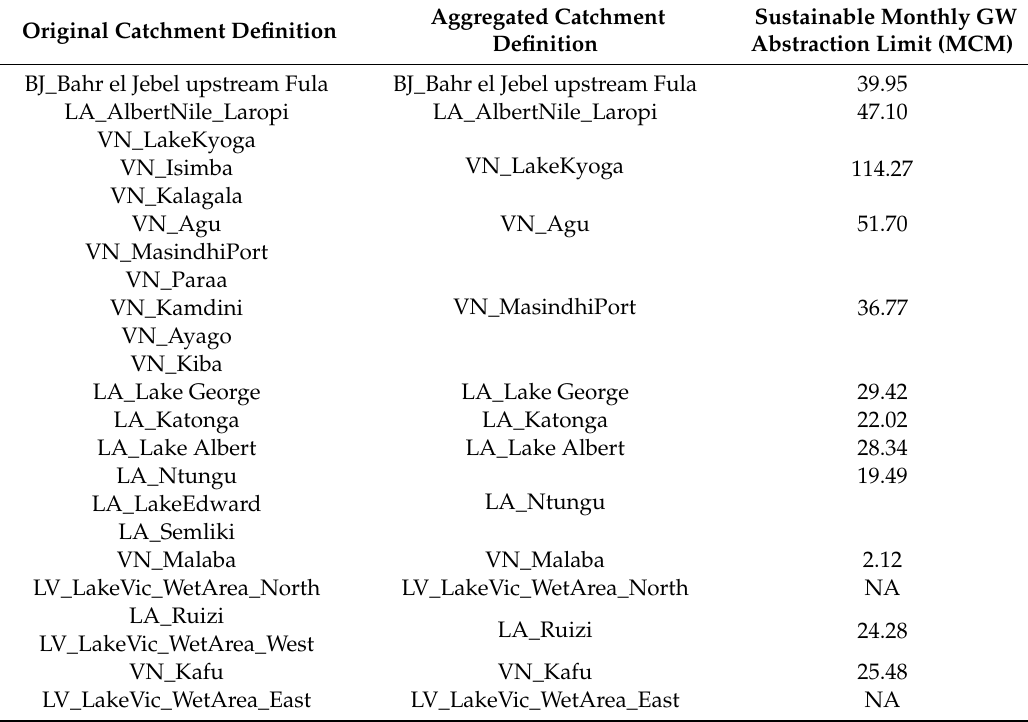
Table A4. Sustainable monthly GW abstraction limit (million cubic